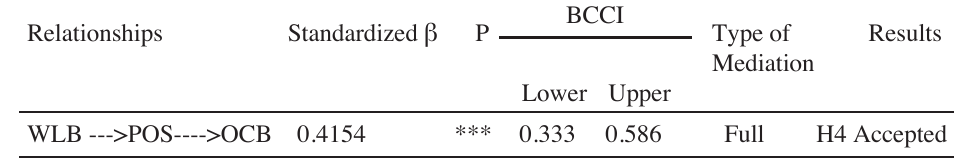
Mediation based on Indirect